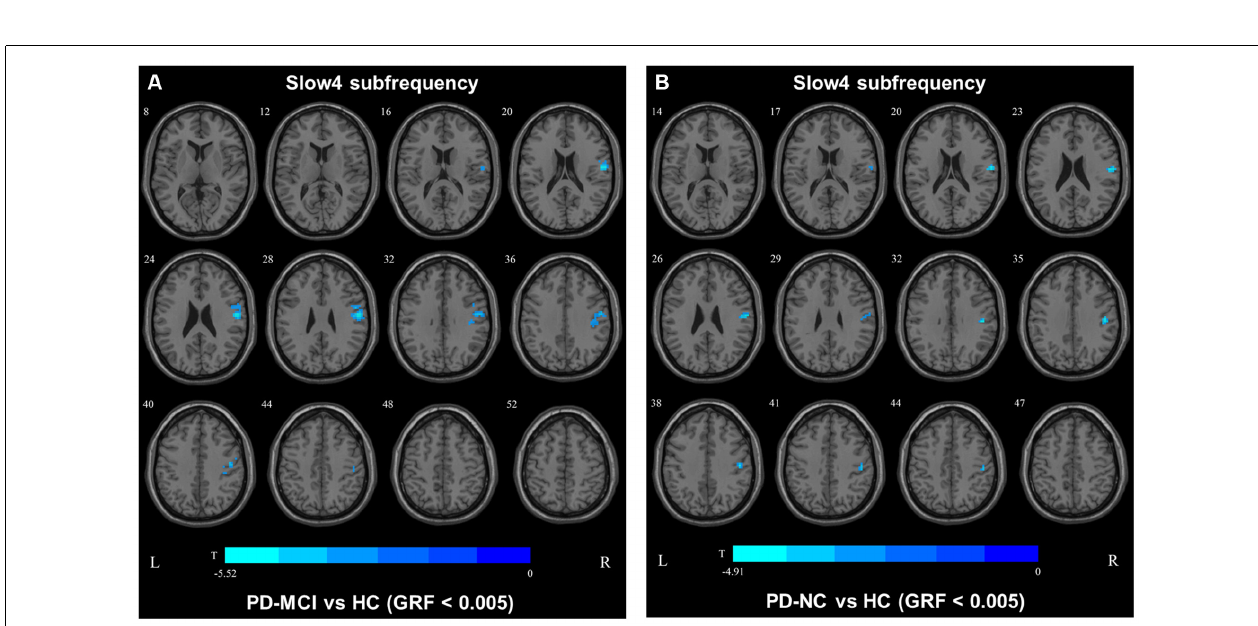
FIGURE 4 | Fractional amplitude of low-frequency fluctuation (fALFF) map differences among the groups in conventional frequency band. The fALFF results were compared by two sample t -tests (GRF corrected, voxel p < 0.005, cluster p < 0.05). The color bar on the bottom indicates the statistical t value. The cold color indicates a significantly decreased fALFF in the comparison. Additional details regarding these regions with difference are shown in Table 3 . (A) Decreased fALFF in PD-MCI patients between PD-MCI and HC. (B) Decreased fALFF in PD-NC patients between PD-NC and HC.